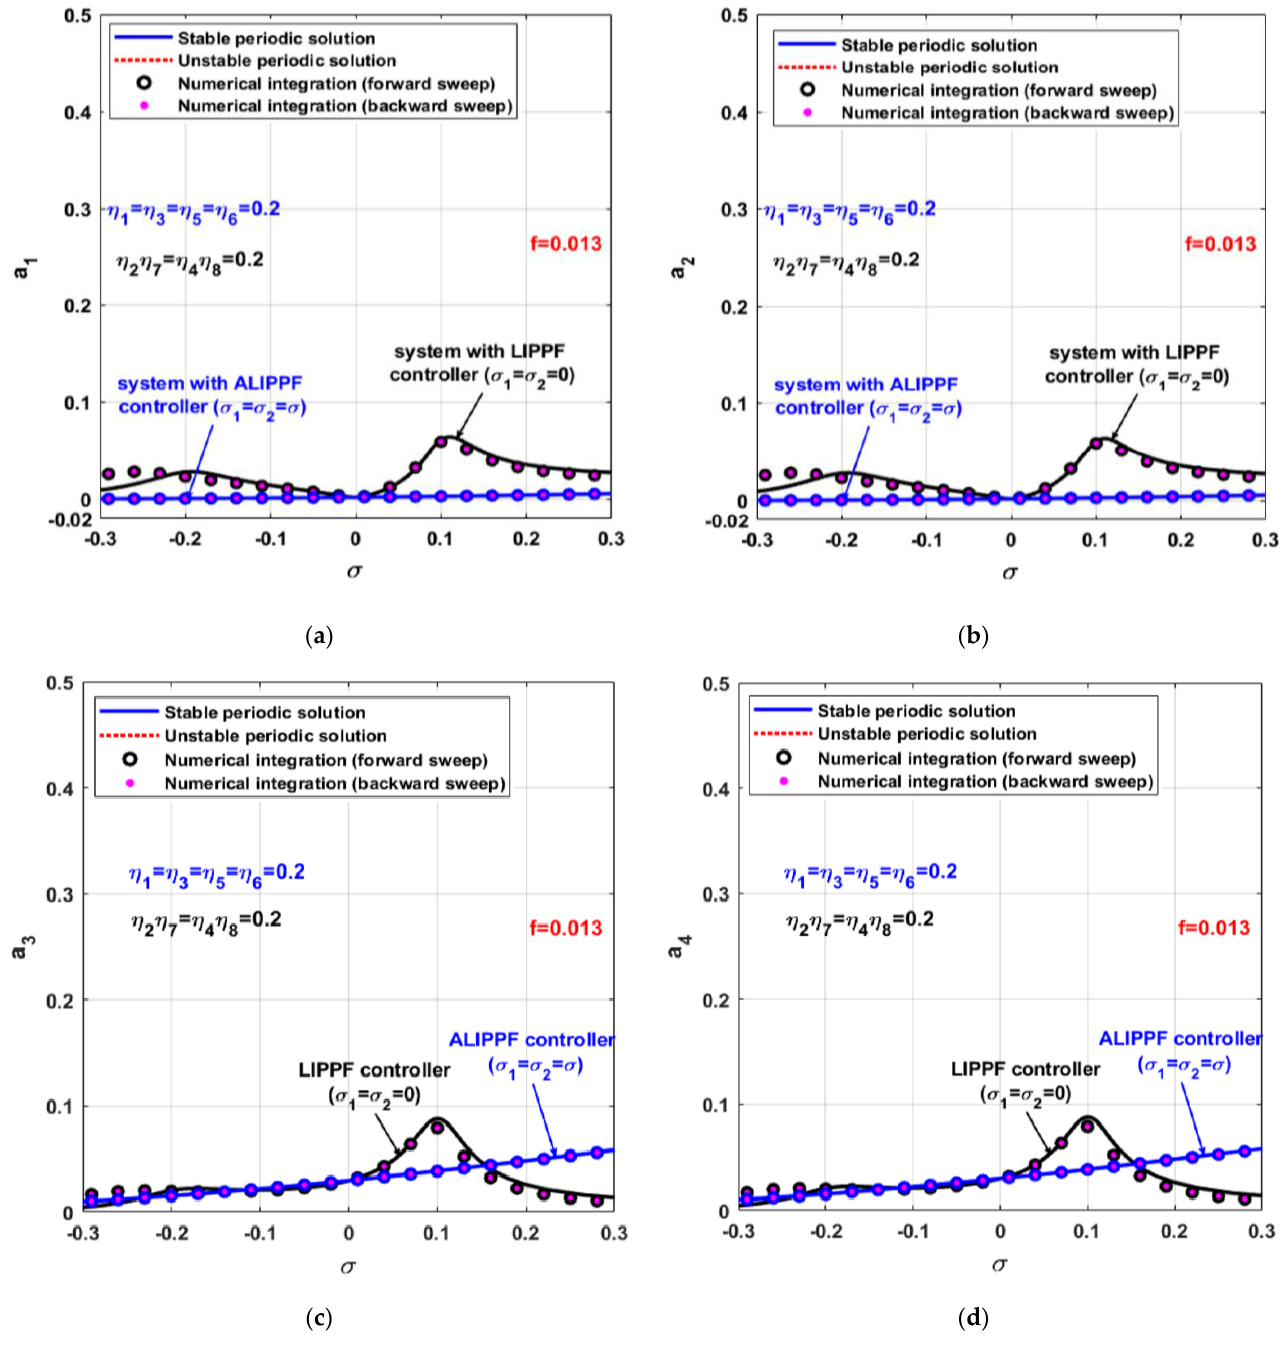
Figure 10. Vibration amplitudes of the rotor system, LIPPF-controller, and ALIPPF-controller when f = 0.013: ( a ) vibration amplitude in X 1 direction, ( b ) vibration amplitude in X 2 direction, and ( c , d ) vibration amplitudes of the LIPPF-controller and ALIPPF-controller.